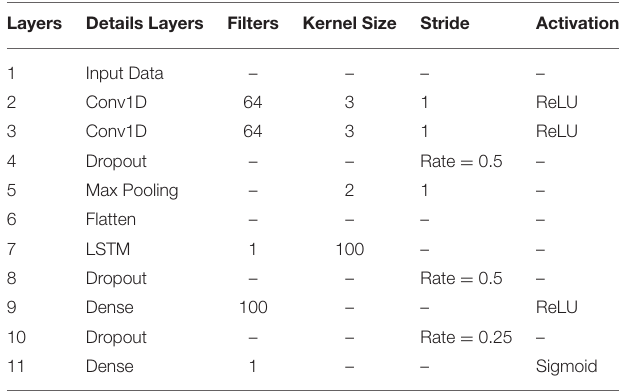
TABLE 6 | The details of the first proposed CNN-LSTM model.